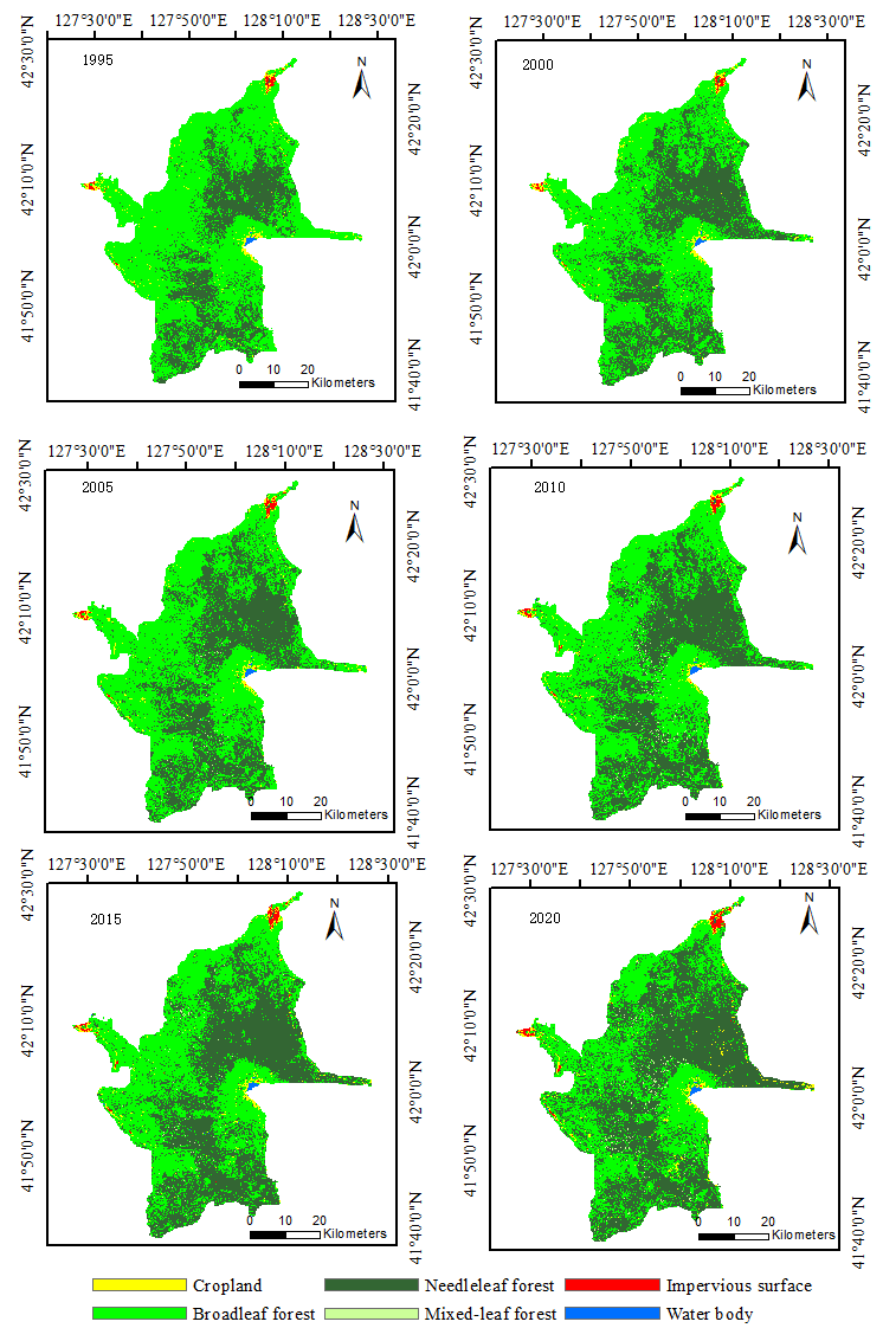
Figure 2. Land Cover Map of the Study Area from 1995 to 2020.